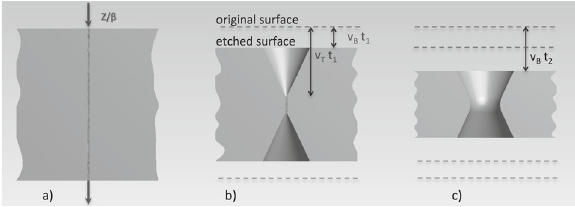
Fig. 7 Illustration of the track-etch technique: a latent track forming along the trajectory of a high ionizing particle impinging perpendic- ularly on the NTD surface; b development of conical pits during the etching process; c etch-pits joining after a prolonged etching, forming a hole in the